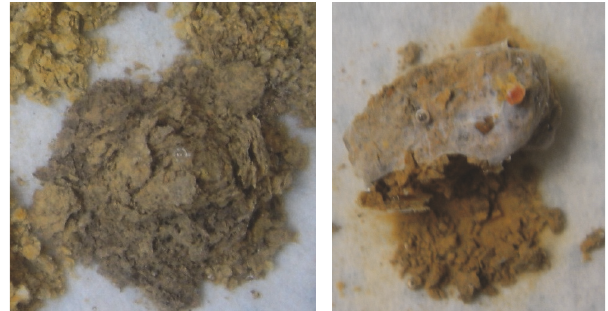
Figure 12: SEM image of soil void filled by STW at × 700 magnifica- tion.